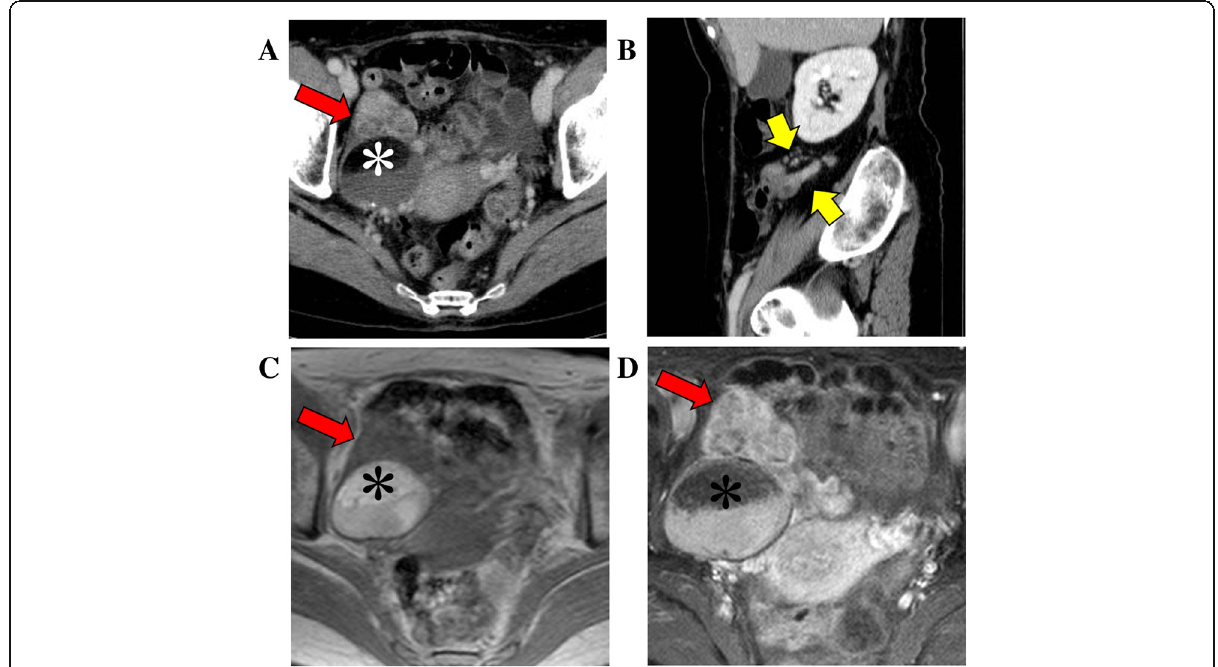
Fig. 1 Clinical imaging. Enhanced computed tomography reveals the presence of: a a 70-mm right ovarian mass with a 40-mm round mass with fat (white asterisk) and solid component with non-uniform enhancement at the ventral side (red arrow) and ( b ) a 10-mm enlarged appendix with strong enhancement (yellow arrows). Magnetic resonance imaging of ( c ) T1-weighted image and ( d ) Fat-saturated T1-weighted image with gadolinium reveals fat (black asterisks), water, and solid components (red